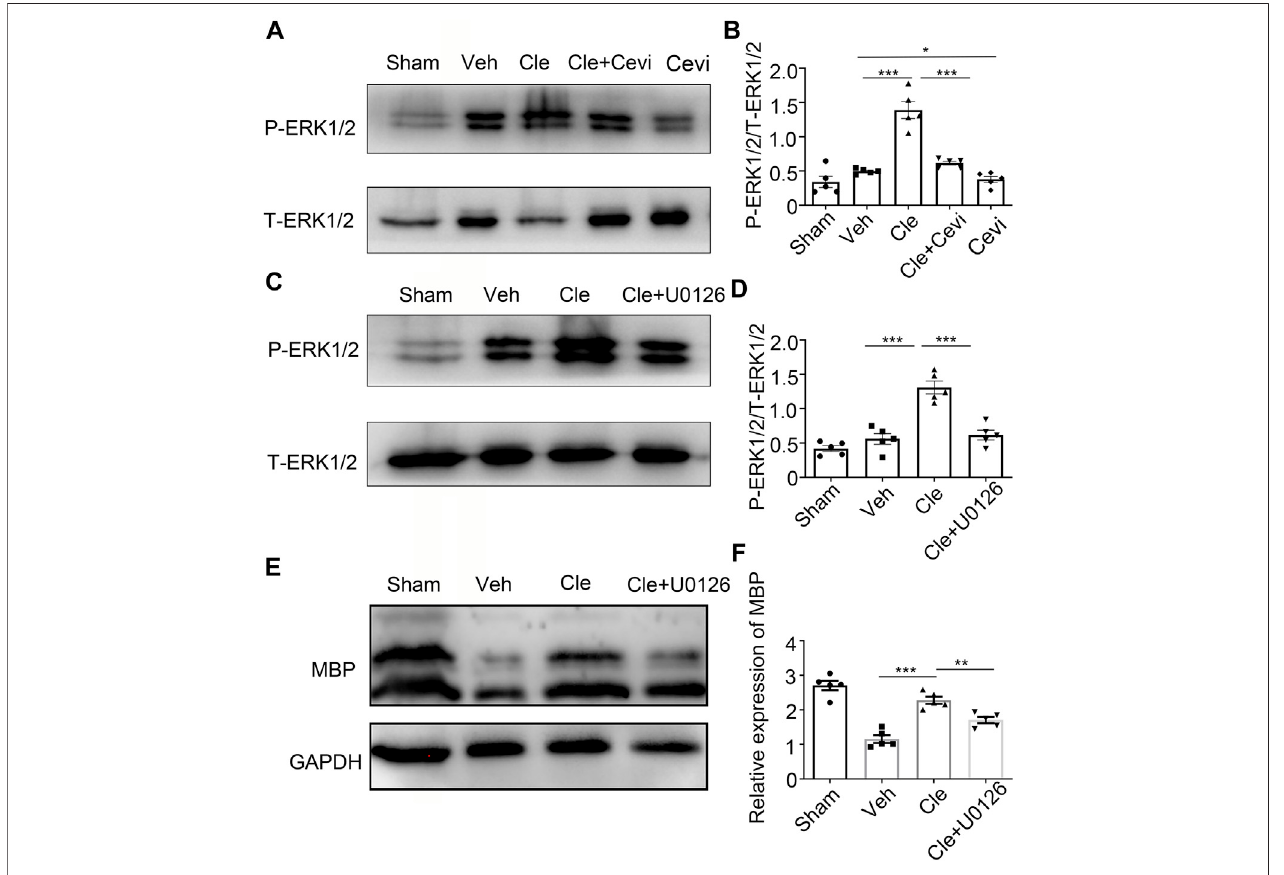
FIGURE 3 | Clemastine promotes OPC differentiation through the upregulation of p-ERK1/2 via MR. (A,C) Protein levels of phosphorylated ERK1/2 and total ERK1/2 were accessed by Western blotting. (B,D) Intensities of p-ERK1/2 were quanti fi ed. Total ERK1/2 expression from the same sample acts as an internal control. (E) Representative Western blots of MBP were performed. (F) Quantitative analysis of protein levels of MBP. The MBP protein levels were normalized to GAPDH. Error bars represent the mean ± SEM ( n = 5 for each group). * p < 0.05, ** p < 0.01, and *** p < 0.001 by Student ’ s t-test with the respective controls.